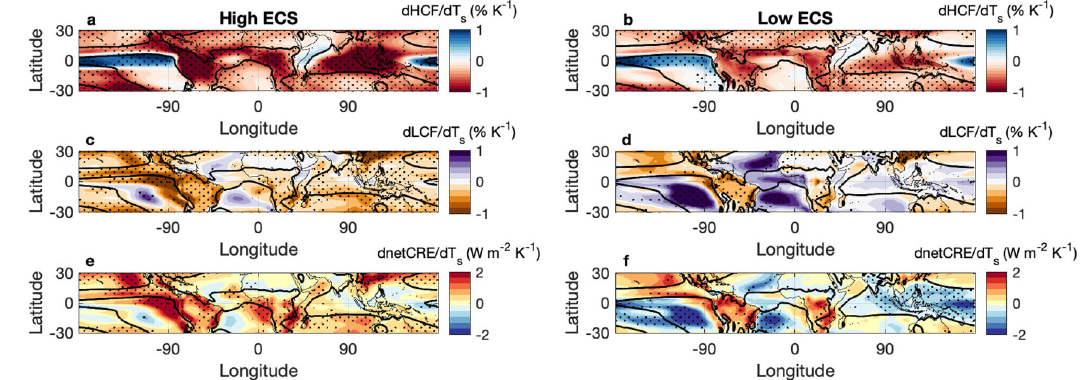
Fig.1|Highandlowcloudfractionreductioncorrespondtoamorepositivenet cloud radiative effect and higher climate sensitivity. Composite maps of